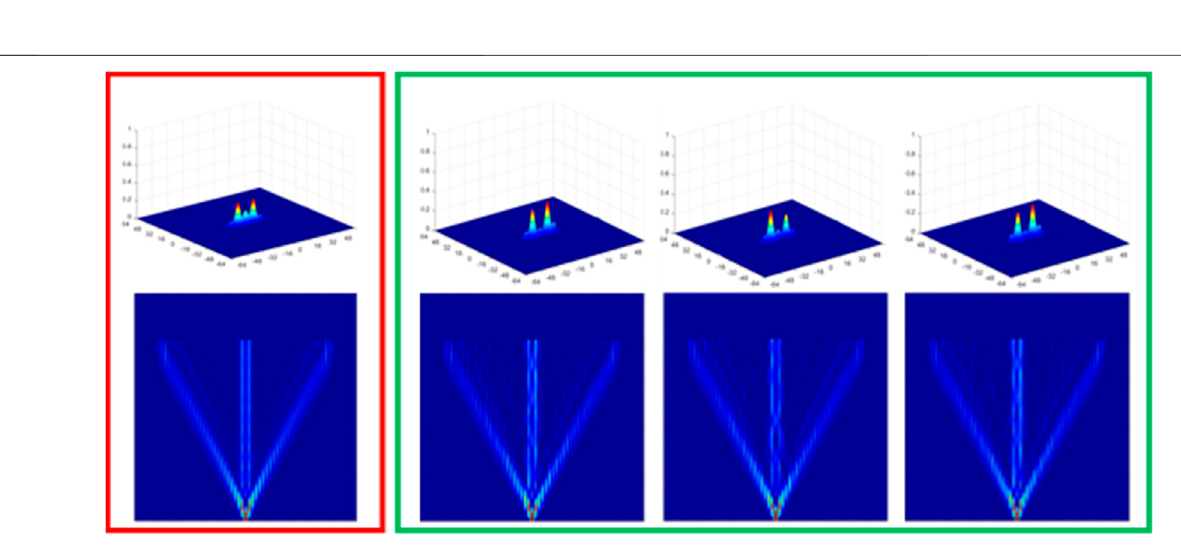
Frontiers in Physics |